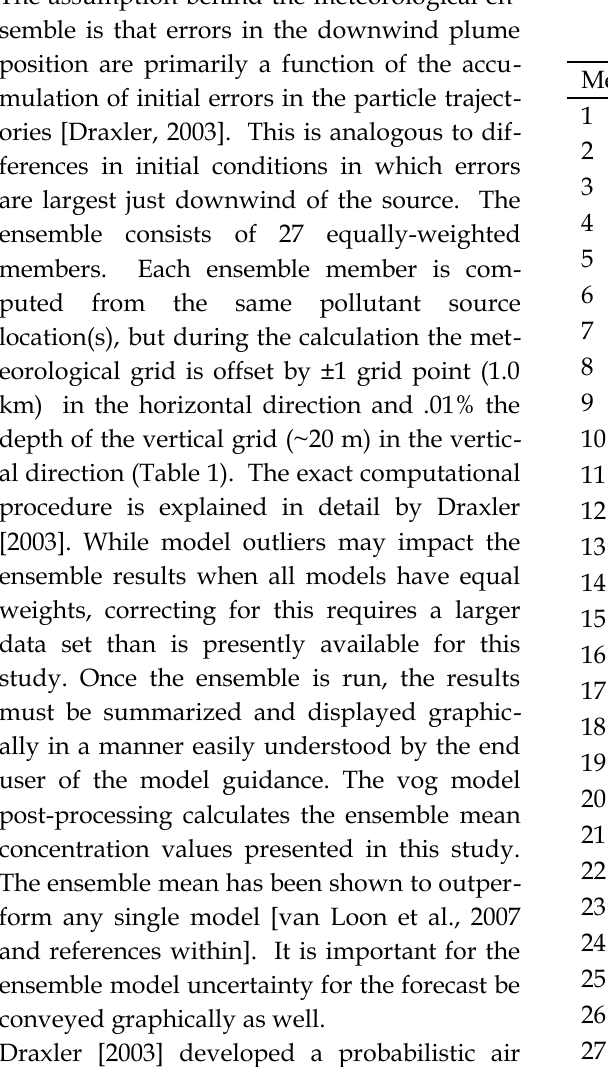
Table 1: List of HYSPLIT ensemble members and their grid offsets. Model 10, with no grid offsets, is closest to the operational model configuration. Adapted from Draxler